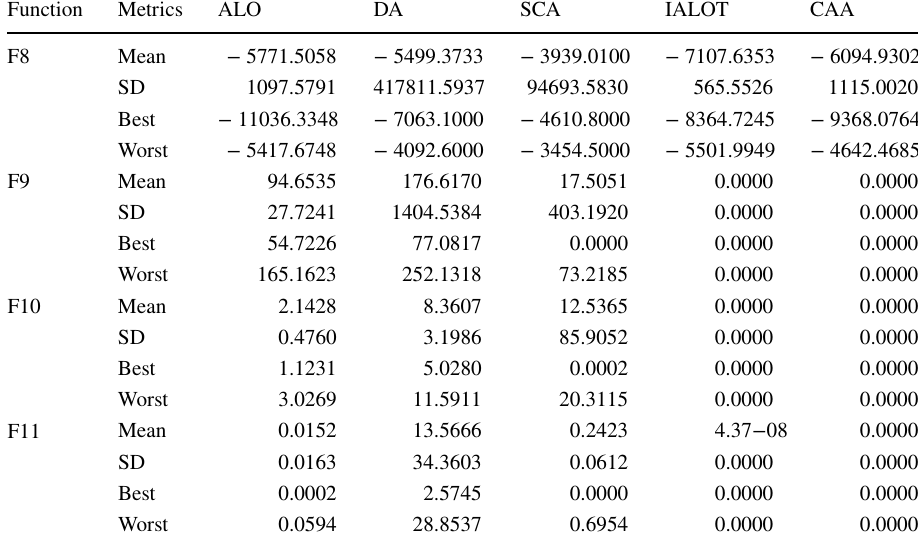
Table 4 Experimental results on multidimensional multimodal functions based on different algorithms